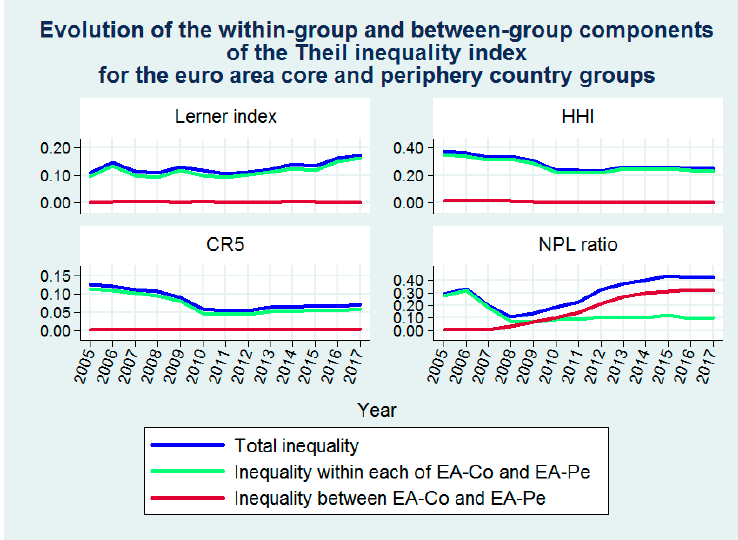
Figure 5. Evolution of the within-group and between-group components of the Theil inequality index for the euro area core and periphery country groups. Source: BankScope database, ECB, World Bank, own calculations. J. Risk Financial Manag. 2020 , 13 , x FOR PEER REVIEW 18 of 26